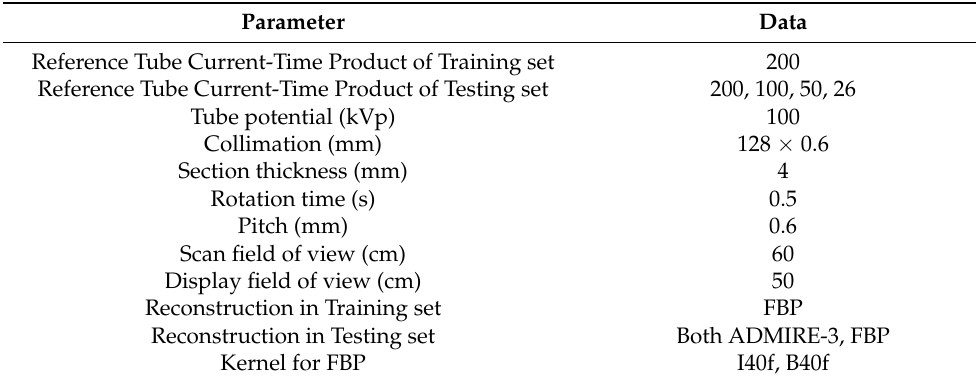
Table 1. Computed tomography (CT) scan and reconstruction parameters for the training and testing of the DLA.